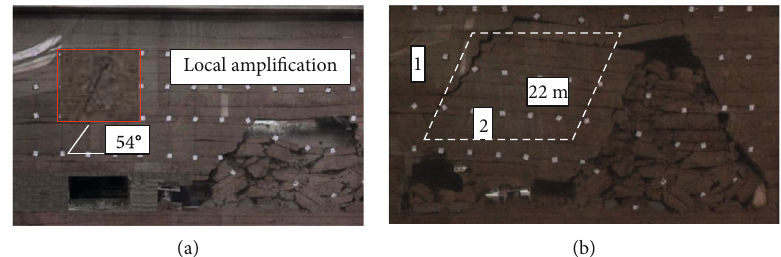
Figure 4: The deformation of the overlying strata in the model. (a) The width of coal between the working face and abandoned roadway is 3.45m. (b) The working face is connected with the roof caving area. 1 — crack width increased; 2 — rotary subsidence of rock block.